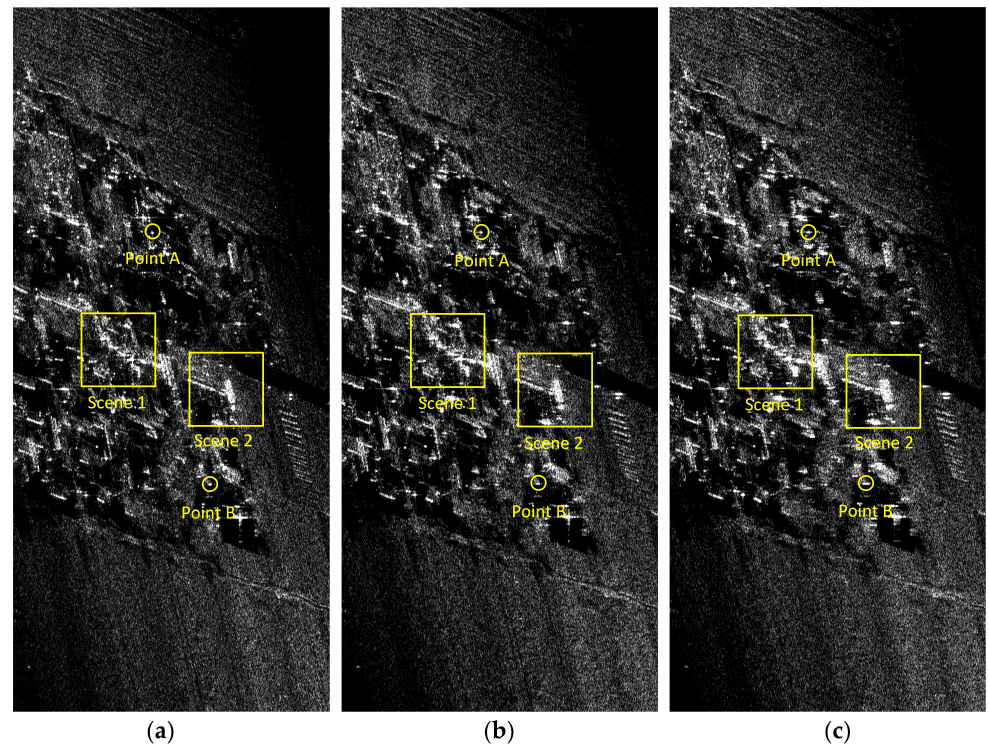
Sensors 2017 , 17 , 2454 16 of 19 Figure 10. Imaging result processed with different algorithms ( a ) FDFBPA; ( b ) PTA ( c ) Two-step MOCO. Table 3. Comparison of Quantification Statistics Results.